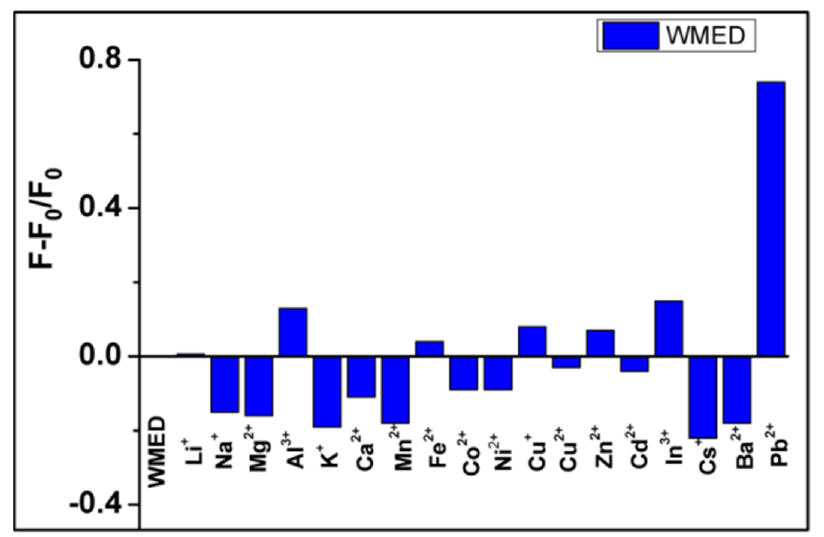
Figure 5. Selectivity of the WMED to different metal ions. The concentration of Pb 2+ and other metal ions was 1 × 10 − 4